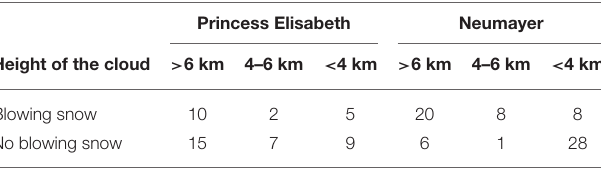
TABLE 7 | Classification of cloudy events detected by both sensors, per cloud top height above ground (as detected by CALIOP). Princess Elisabeth